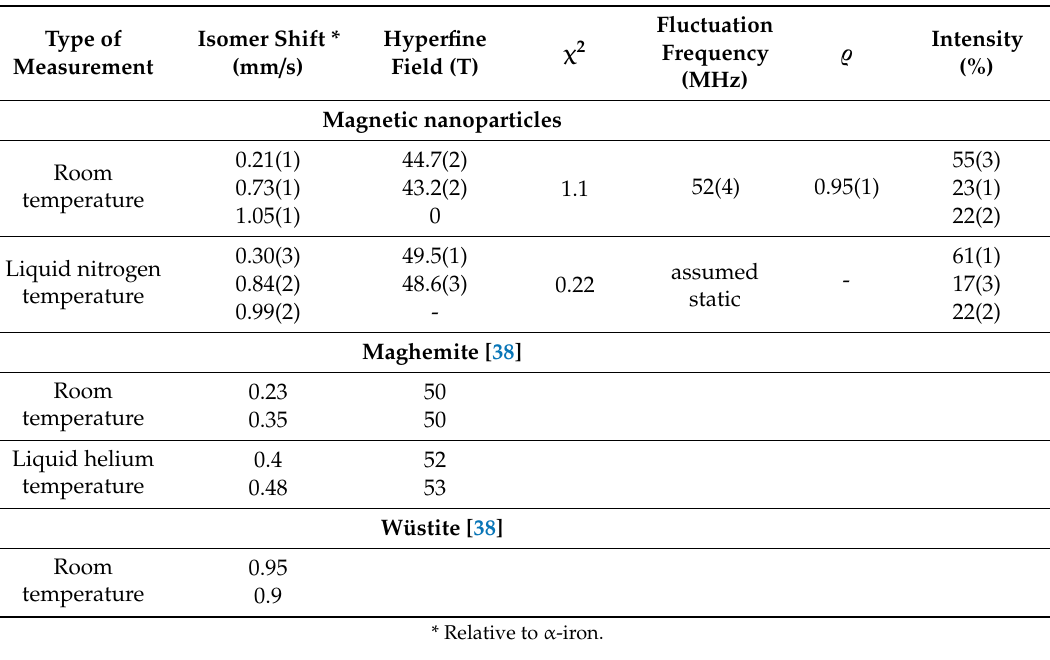
Table 1. Hyperfine parameters obtained from the fits of Mössbauer spectra together with those for reference materials taken from the literature. ρ is the asymmetry parameter, i.e., the relative residence time of nanoparticle moment along its easy direction.